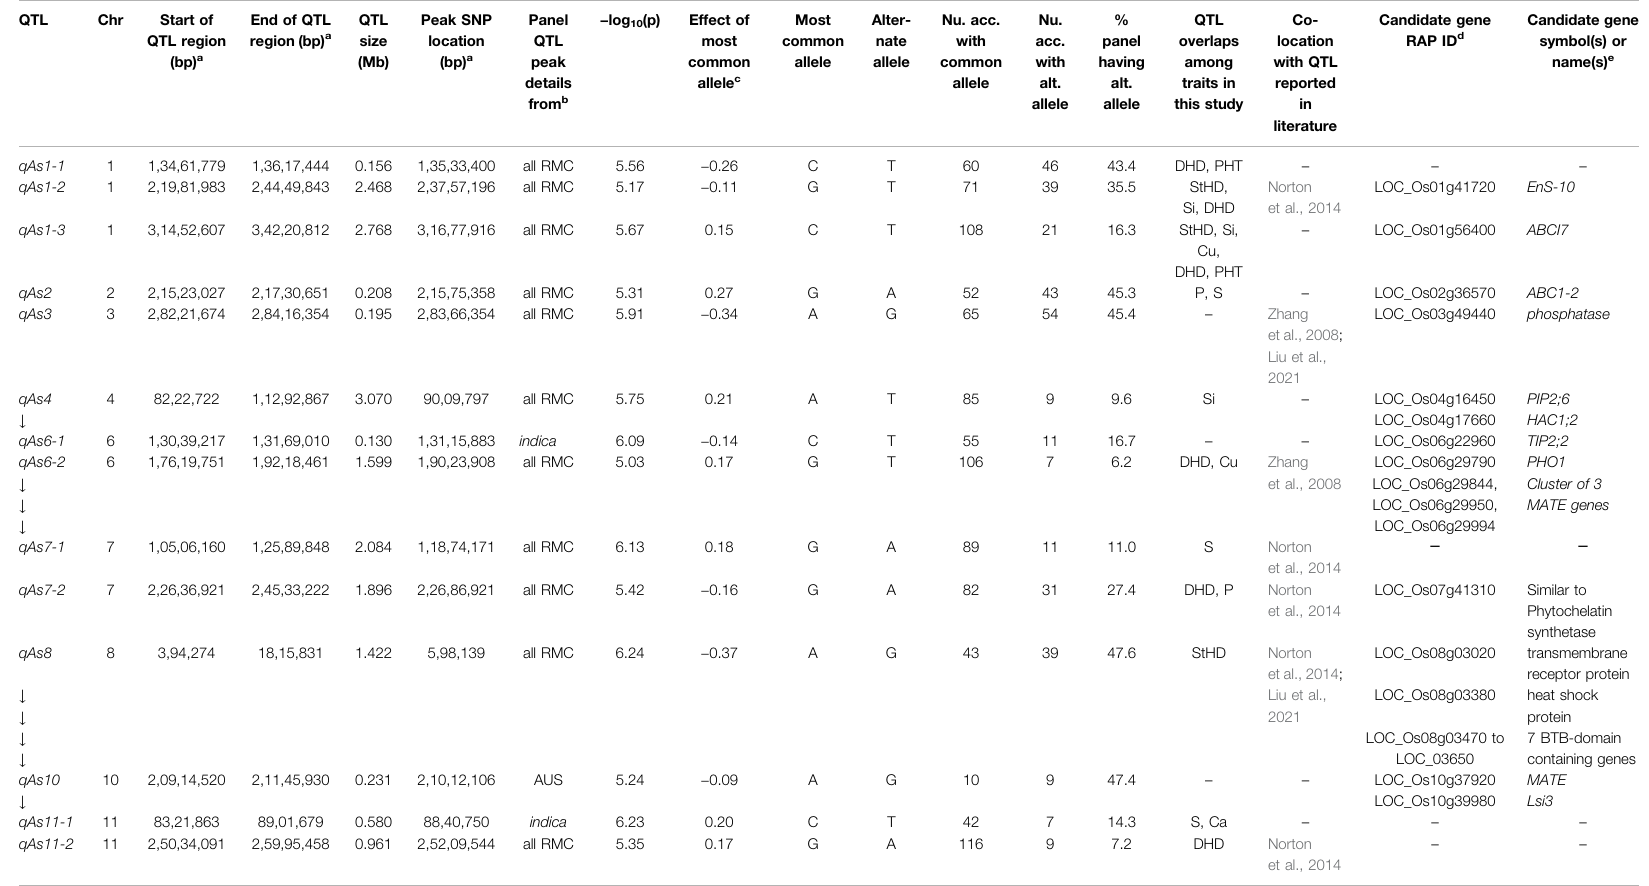
TABLE 4| QTL associated byGWAwithgrain arsenicconcentration (qAs) intheRice MinicorePanel (RMC) arrangedinchromosomal order.Overlaps withQTLforother traits within thisstudy,and candidate genesarealso noted. Panels for which QTL are listed include “ all RMC ” containing all RMC accessions, indica subspecies, japonica subspecies, IND subgroup, and AUS subgroup. QTL Chr Start of